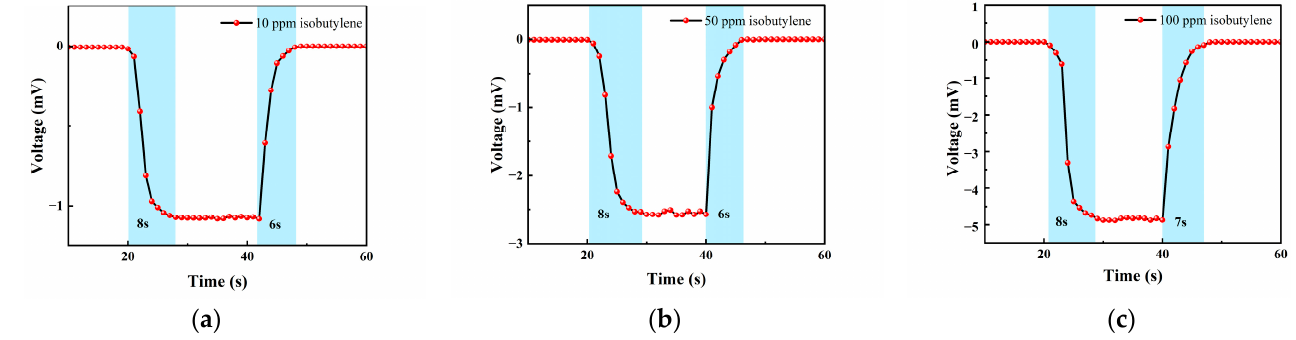
Figure 13. ( a ) A 10 ppm isobutylene gas response–recovery time; ( b ) 50 ppm isobutylene gas re- sponse–recovery time; and ( c ) 100 ppm isobutylene gas response–recovery time. response–recovery time; and ( c ) 100 ppm isobutylene gas response–recovery time.